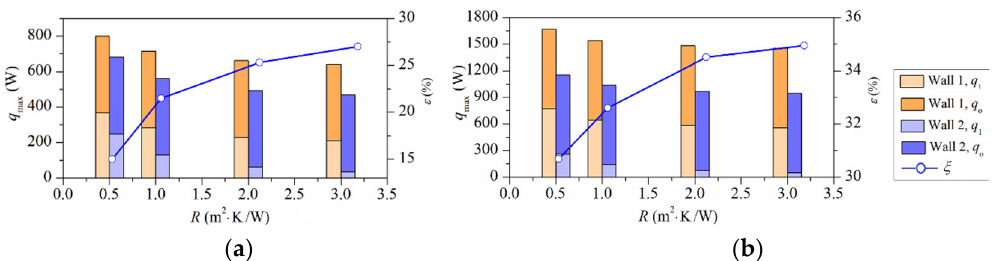
Figure 10. Comparison of the peak load between the externally and internally wall with respect to different insulation resistance; ( a ) in cooling season; ( b ) in heating season.